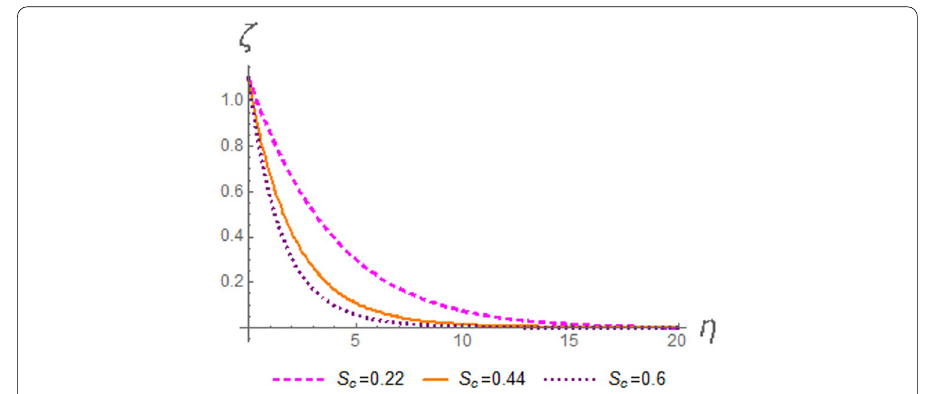
Fig. 13 Effect of S c on the concentration profile